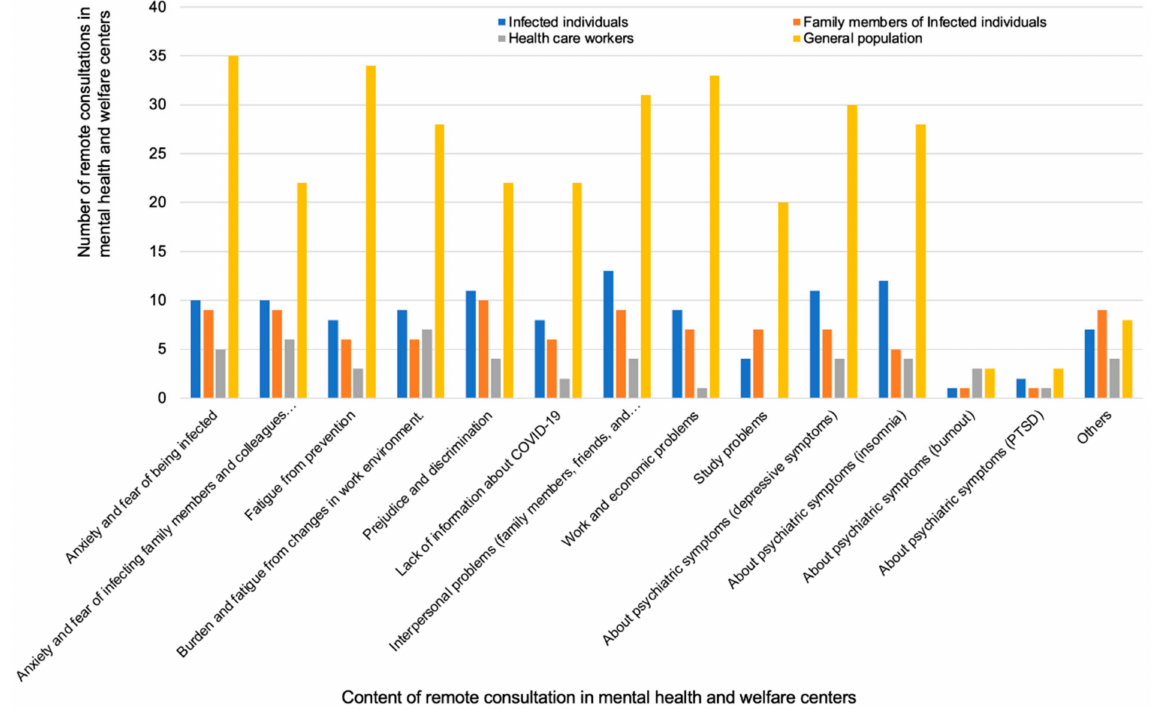
Figure 8. Number of remote consultations by content in mental health and welfare